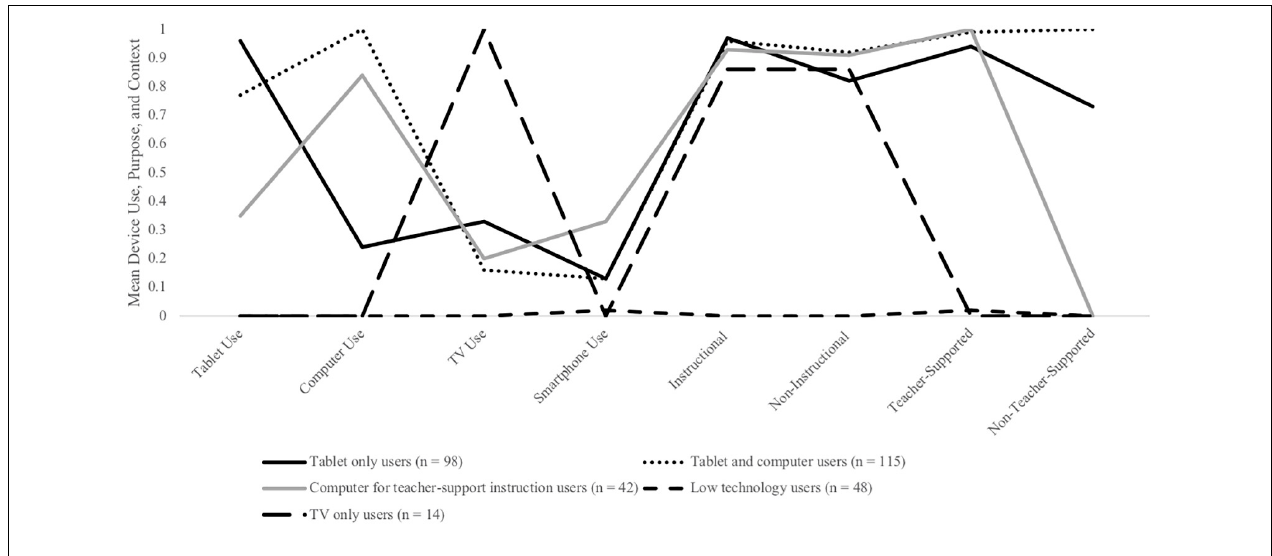
FIGURE 1 | Mean device use, purpose, and context for the five classes identified by LCA.